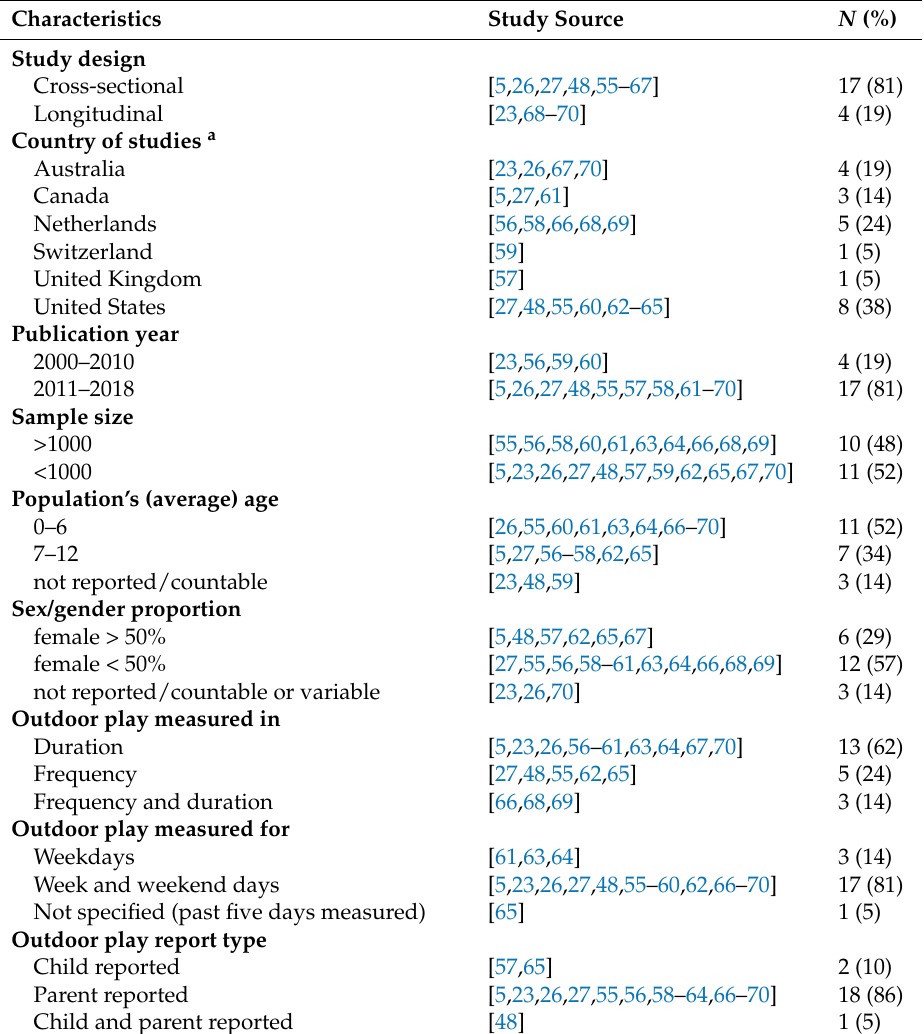
Table 1. Characteristics of included studies ( N =